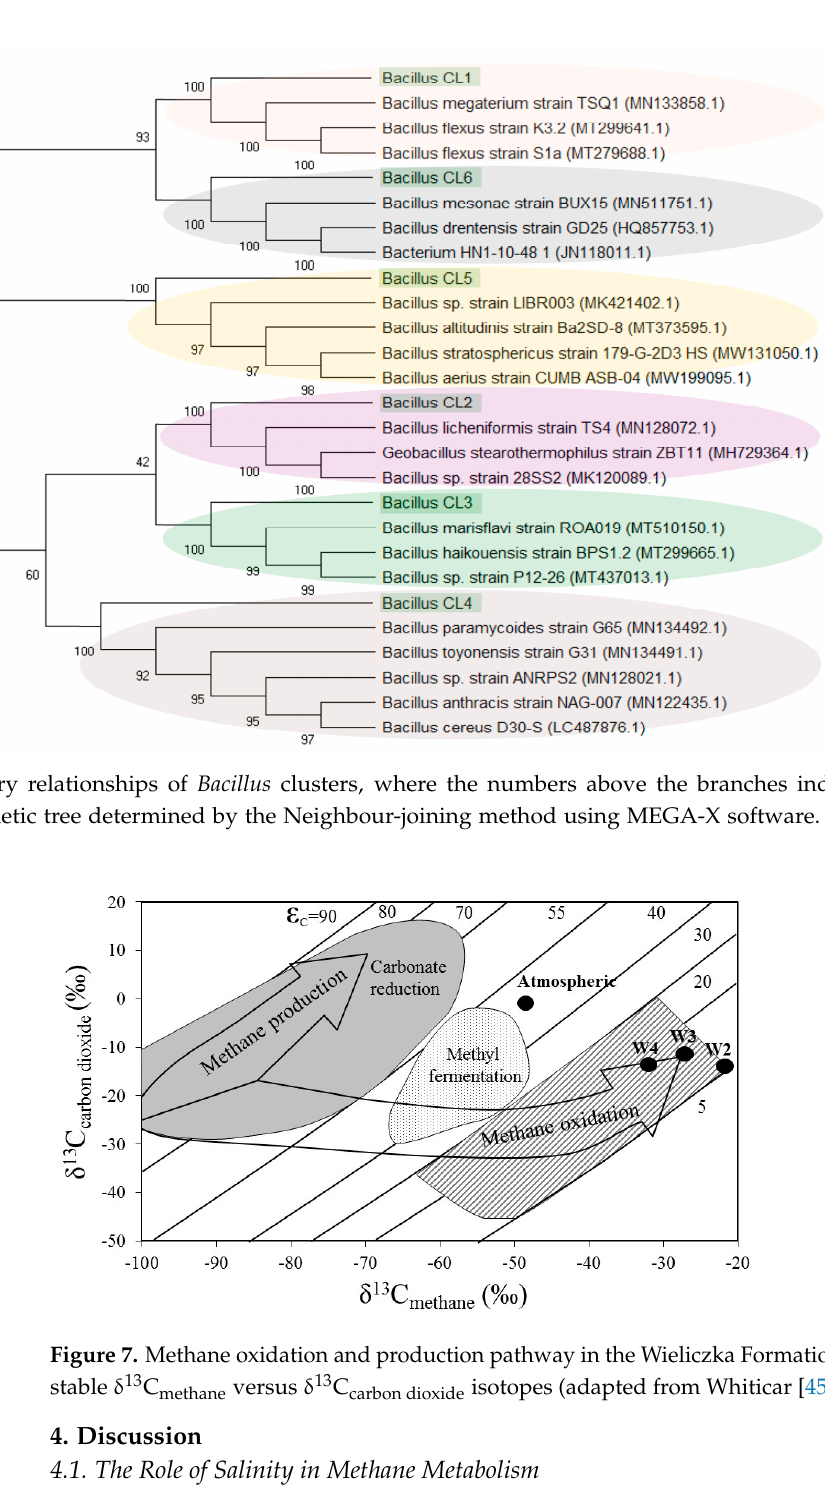
Figure 7. Methane oxidation and production pathway in the Wieliczka Formation sediments through stable δ 13 C methane versus δ 13 C carbon dioxide isotopes (adapted from Whiticar [45]).